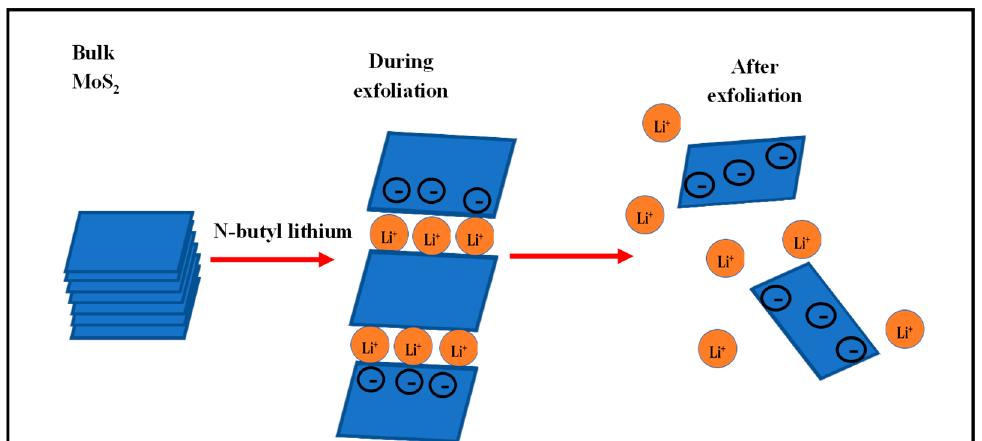
Figure 4. Liquid exfoliation of bulk MoS 2 using lithium intercalation.